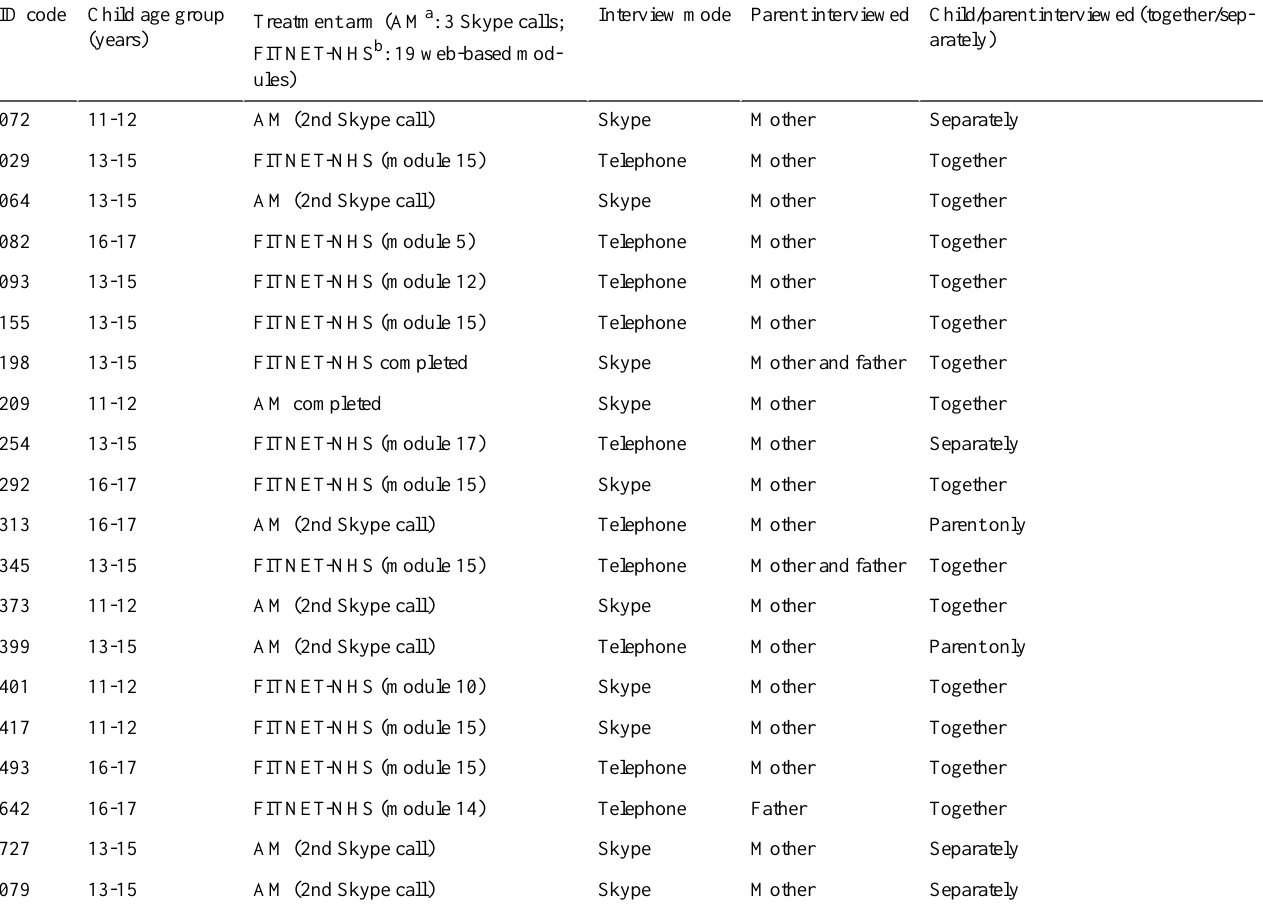
Table 1. Details of the children and parents